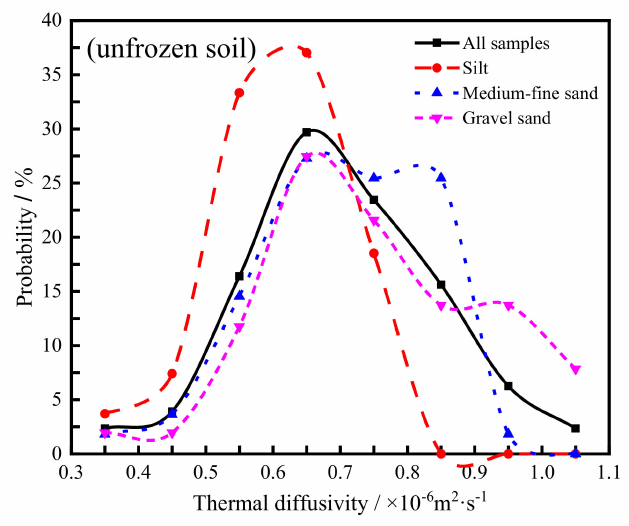
Figure 6. Probability distribution of thermal diffusivity of unfrozen soil with different particle sizes.